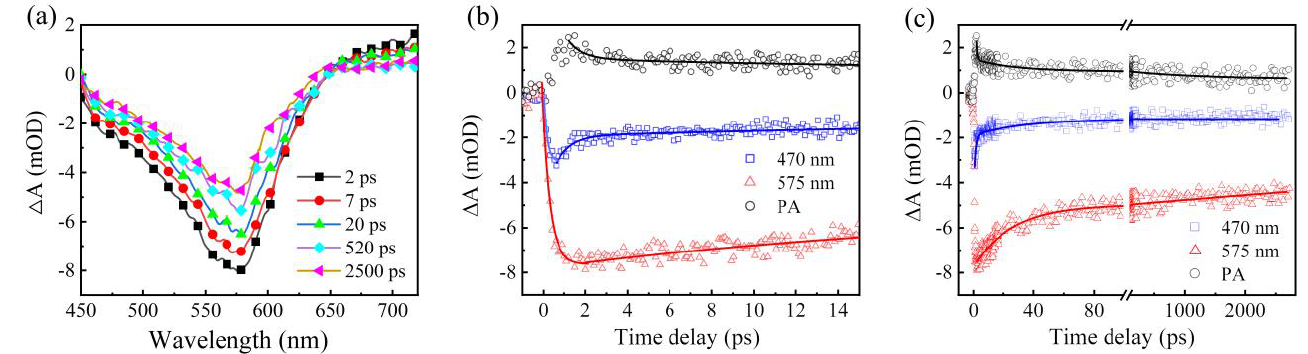
Figure 3. ( a ) TA spectra of CS − QDs pumped at 400 nm. The formation process ( b ) and decay dy- namics ( c ) at 575 nm, 470 nm and PA extracted from ( a ). The solid lines are fit